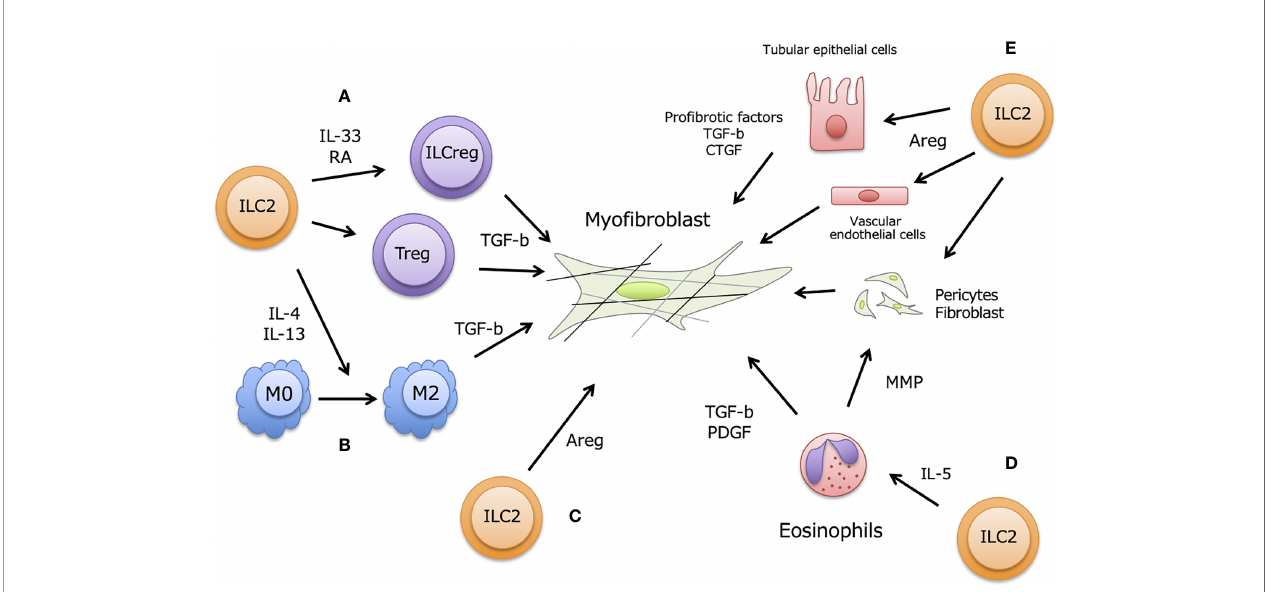
FIGURE 2 | ILC2 contribution for renal fi brosis. Renal fi brosis is partially induced by pro- fi brotic factors including TGF- b from M2 macrophages, Tregs, and ILCs, and fi broblasts accelerate trans-differentiation to myo fi broblasts in renal stromal region. Activation of myo fi broblast occurs excessive ECM deposition, leading to impair renal functions. Renal ILC2 possibly contribute to enhance fi brosis at following aspects of myo fi broblast activation; (A) ILC2-ILCreg plasticity, (B) M2 macrophages differentiation, (C) direct effect by Areg production, (D) indirect effect via eosinophils induced by IL-5, (E) Effect of Areg to produce pro- fi brotic factors on tubular epithelial cells, vascular endothelial cells, fi broblasts and